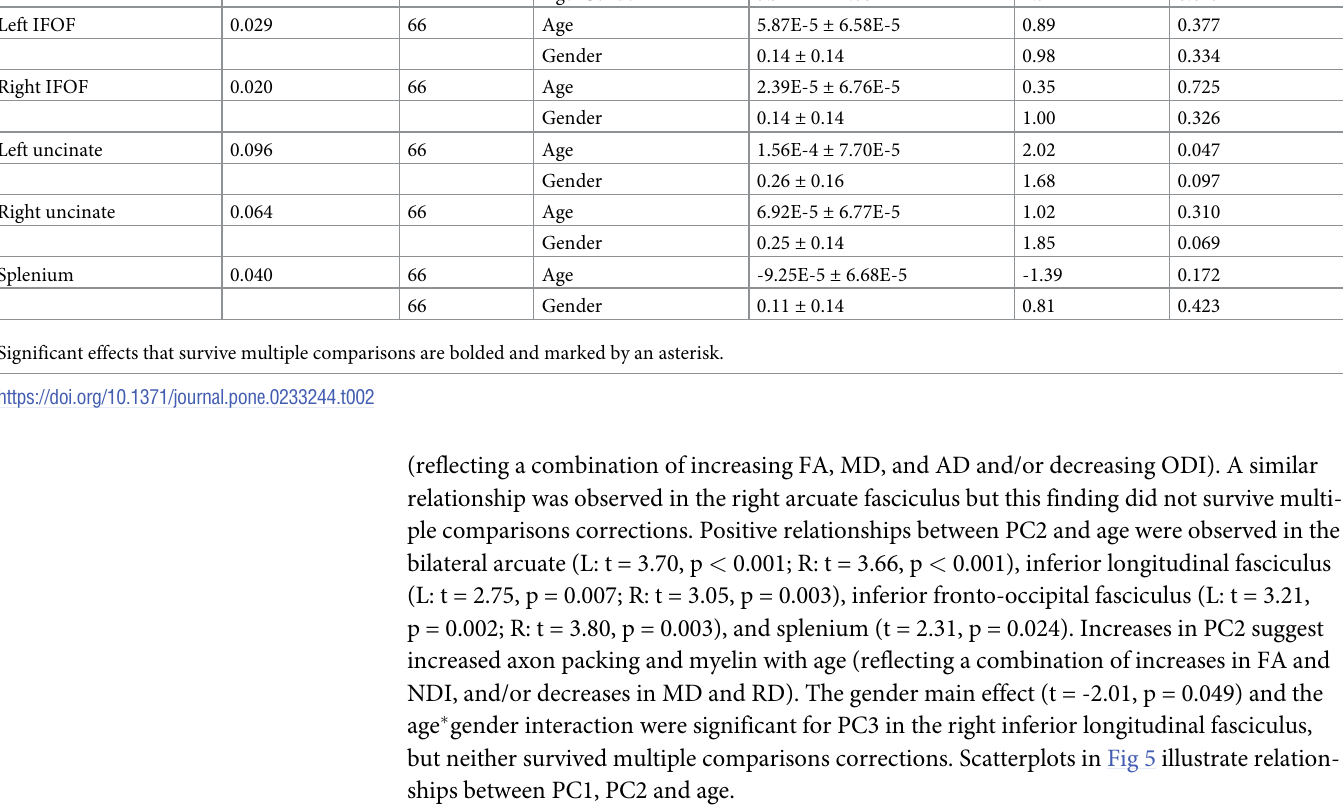
(reflecting a combination of increasing FA, MD, and AD and/or decreasing ODI). A similar relationship was observed in the right arcuate fasciculus but this finding did not survive multi- ple comparisons corrections. Positive relationships between PC2 and age were observed in the bilateral arcuate (L: t = 3.70, p < 0.001; R: t = 3.66, p < 0.001), inferior longitudinal fasciculus (L: t = 2.75, p = 0.007; R: t = 3.05, p = 0.003), inferior fronto-occipital fasciculus (L: t = 3.21, p = 0.002; R: t = 3.80, p = 0.003), and splenium (t = 2.31, p = 0.024). Increases in PC2 suggest increased axon packing and myelin with age (reflecting a combination of increases in FA and NDI, and/or decreases in MD and RD). The gender main effect (t = -2.01, p = 0.049) and the age � gender interaction were significant for PC3 in the right inferior longitudinal fasciculus, but neither survived multiple comparisons corrections. Scatterplots in Fig 5 illustrate relation- ships between PC1, PC2 and age.